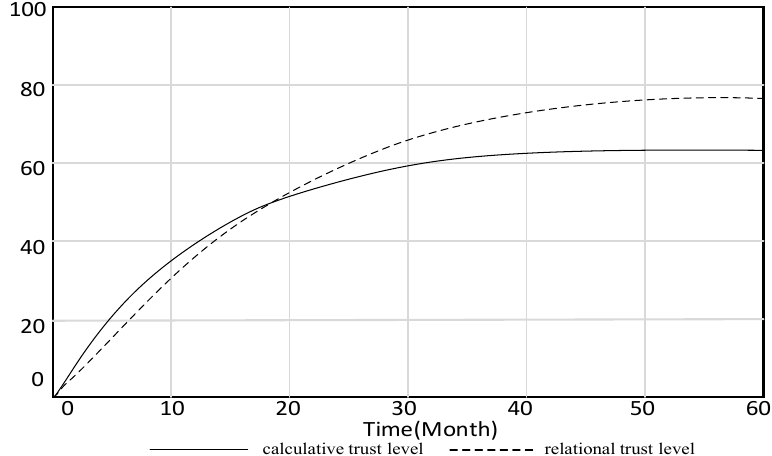
Figure 6. Dynamic evolution curve of trust level.